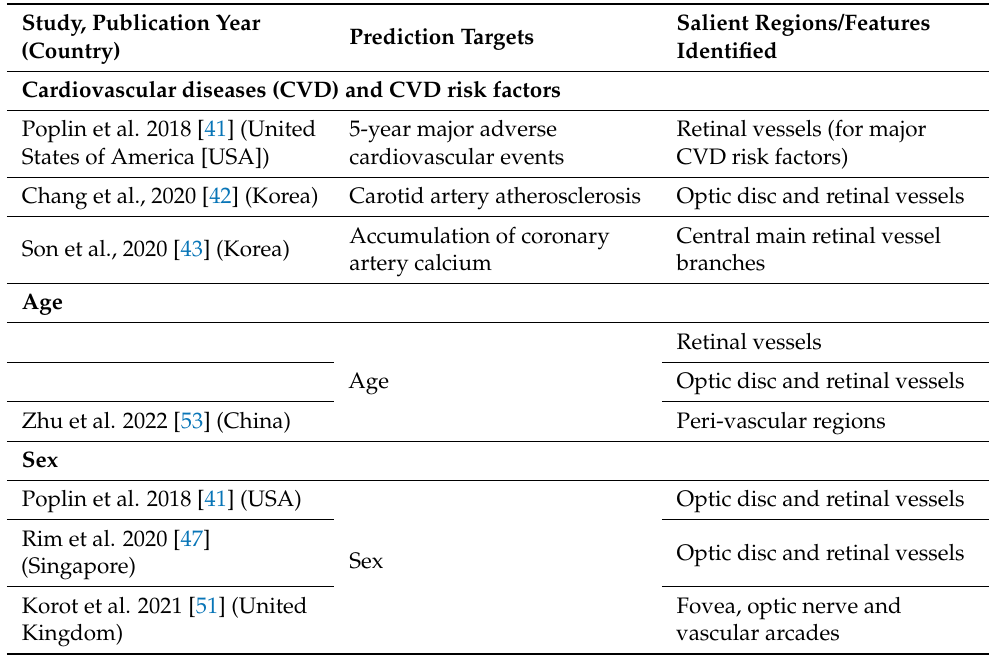
Table 1. Salient retinal fundus regions/features associated with deep learning